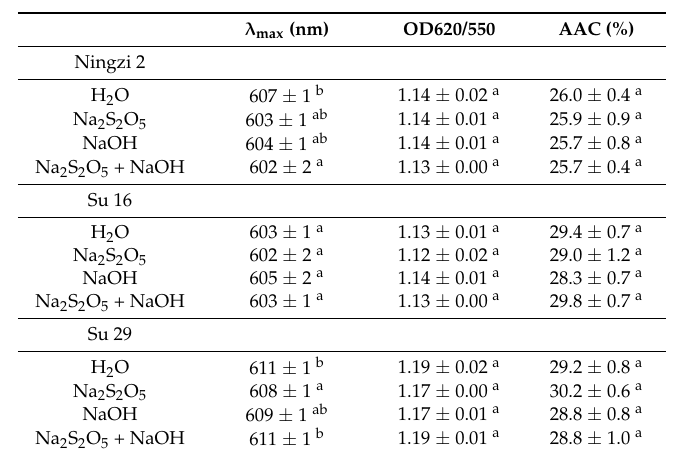
Figure 3. Spectra of iodine absorbance of starches. Table 3. Maximum absorption wavelength ( λ max ), iodine absorbance ratios of OD620 to OD550 (OD620/550), and apparent amylose contents (AAC) of starches.